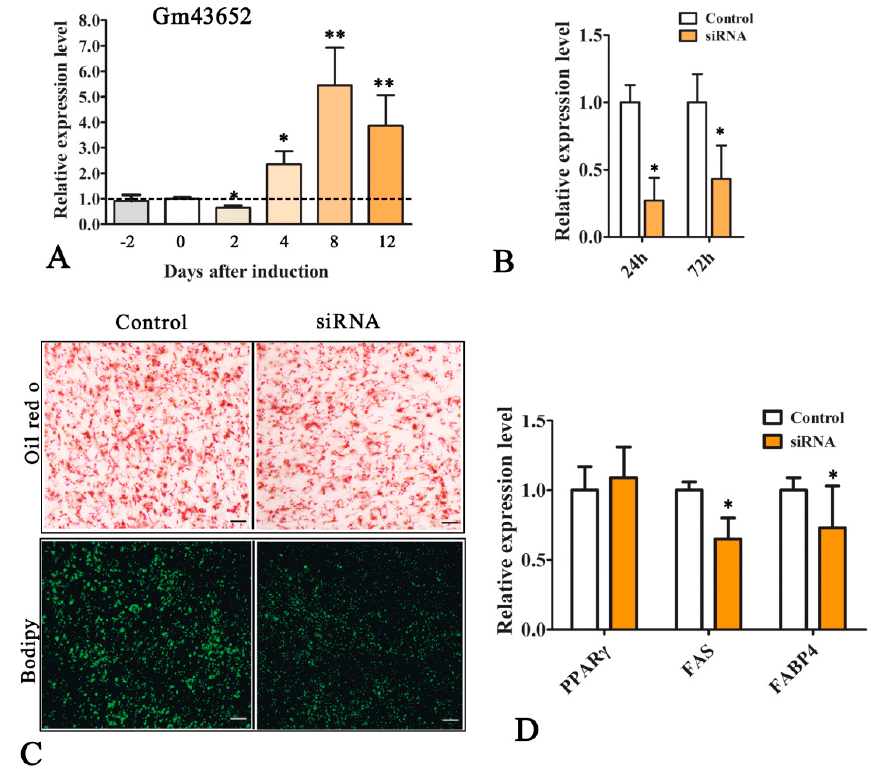
Figure 7. The lncRNA-GM43652 gene is a potential regulator of the adipogenic conversion of C2C12 myoblasts. ( A ) Changes in the expression of lncRNA-GM43652 during adipogenic transdifferentiation of myoblasts. ( B ) Knock down of lncRNA-GM43652 using small interfering RNAs (siRNAs). ( C ) Knocking down lncRNA-GM43652 decreased lipid deposition in the ADCs. The lipids in cells are stained with Oil Red O and BODIPY. ( D ) Knocking down lncRNA-GM43652 decreased the mRNA levels of the adipogenic genes. Expression levels were detected by qRT-PCR, n = 3. The data are presented as the mean ± SEM. * P ≤ 0.05, student’s t -test.